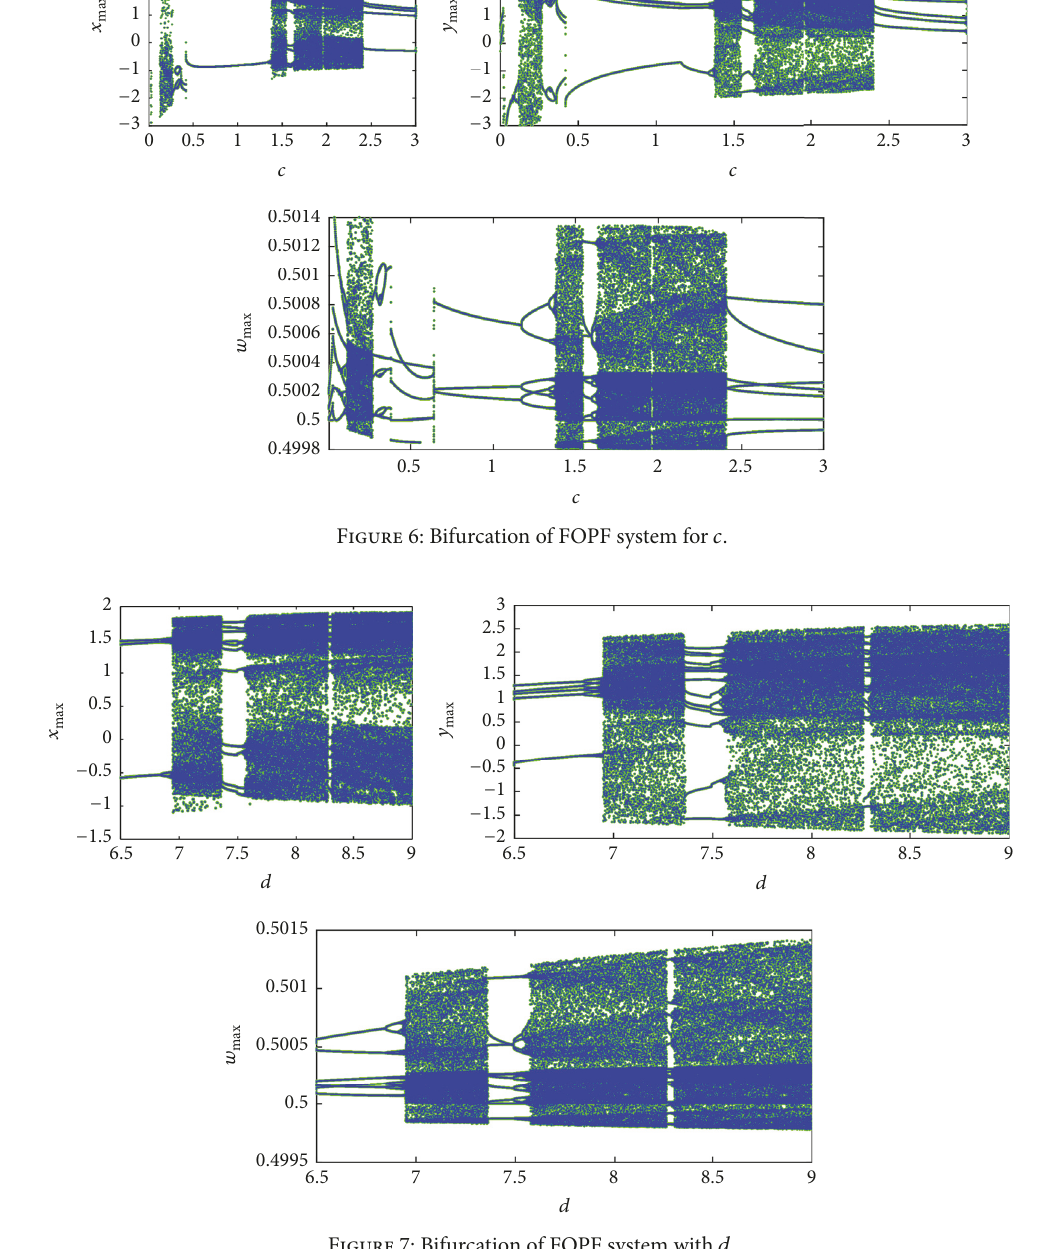
Figure 7: Bifurcation of FOPF system with 𝑑